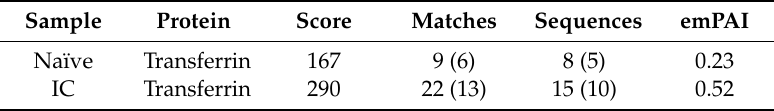
Table 2. Identification of PxTrf protein in P. xylostella.